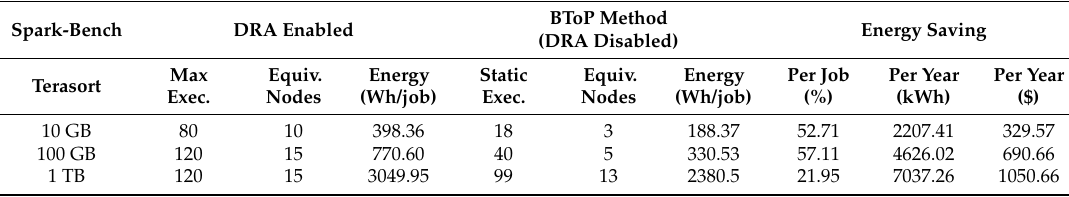
Table 2. Energy savings in using Spark with BToP method in lieu of Dynamic Resource Allocation (DRA) enabled for Spark-Bench Terasort of 10 GB, 100 GB, and 1